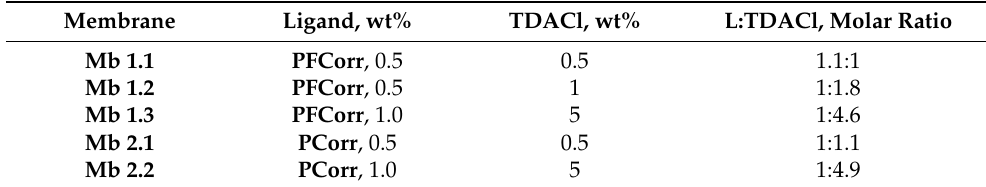
Table 1. Compositions of tested PFCorr - and PCorr -doped membranes, PVC:TOP = 1:2 ratio by